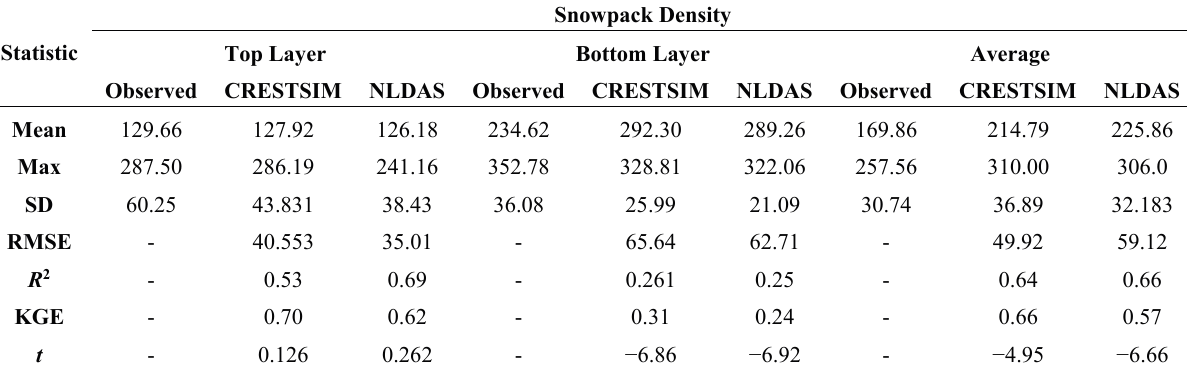
Figure 16. Time series for snow density (kg/m 3 ) in the top layer ( upper ), average ( middle ), and bottom layer ( lower ) of the snowpack. Legend: NLDAS meteorological data simulation (NLDAS), CREST-SAFE meteorological data simulation (CRESTSIM), and manual CREST-SAFE observations (Observed). The number of observations was 29. Table 7. Snow density (kg/m 3 ) statistics for bottom layer and top layer. Validation period: winter 2011–2012. Row definitions are same as in Table 3. The number of observations was